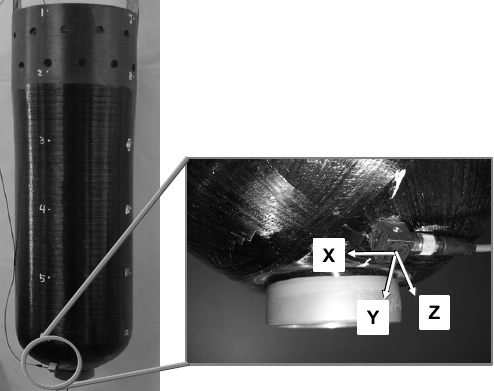
Fig. 12. Filament-wound rocket motor casing that is discretized into 24 possible forcing locations and has a triaxial accelerometer attached.